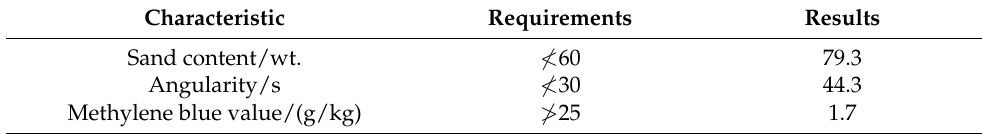
Table 3. Characteristics of fine aggregate. Characteristic Requirements